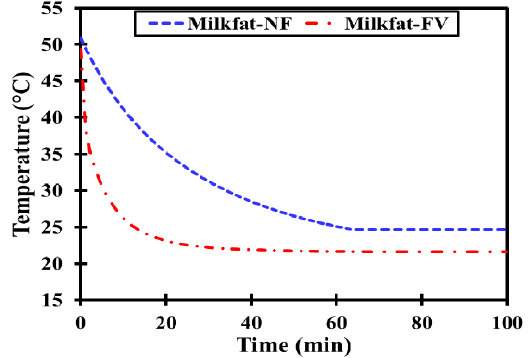
Figure 11. Transient cooling curve for milk fat represented by HS bottom surface temperature under NV and FV.